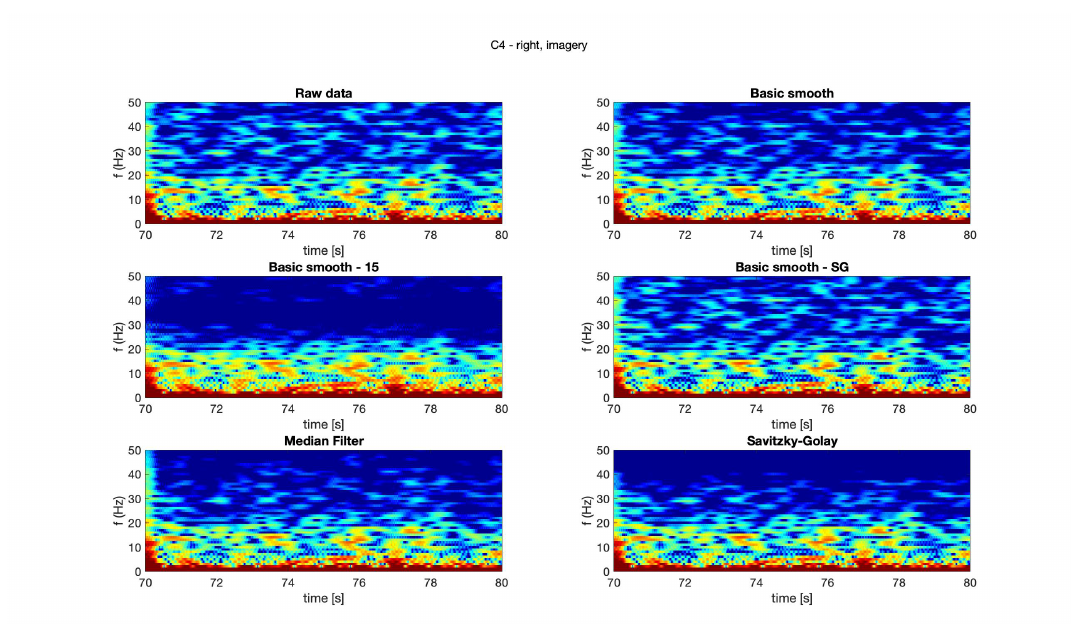
Figure 12. Spectrogram—C4, right hand, imagery